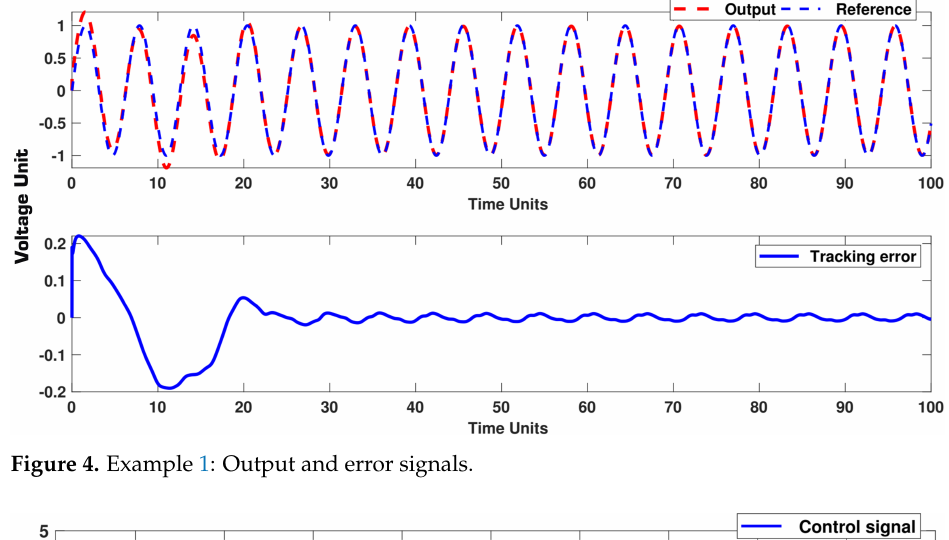
Figure 4. Example 1: Output and error signals.